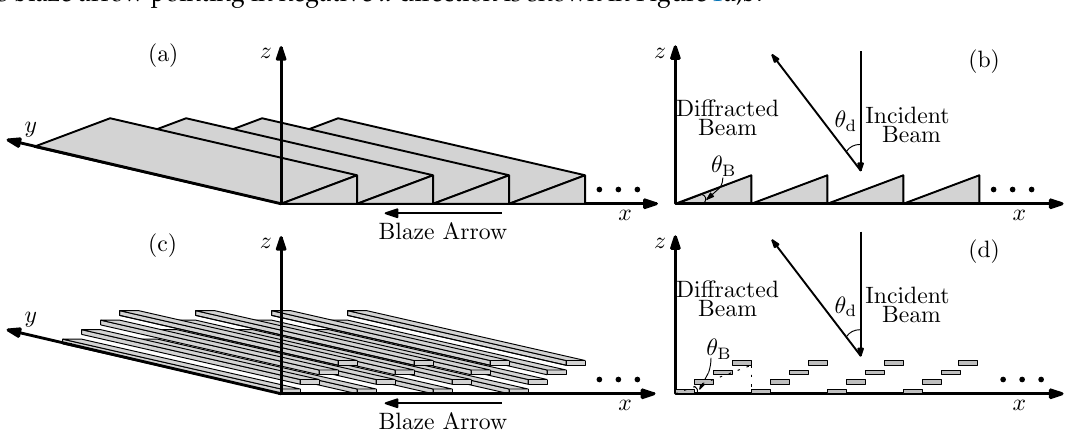
Figure 1. A sawtooth-shaped grating in the ( a ) perspective view and ( b ) side view. An approximate blazed grating using subwavelength MEMS reflectors in the ( c ) perspective view and ( d ) side